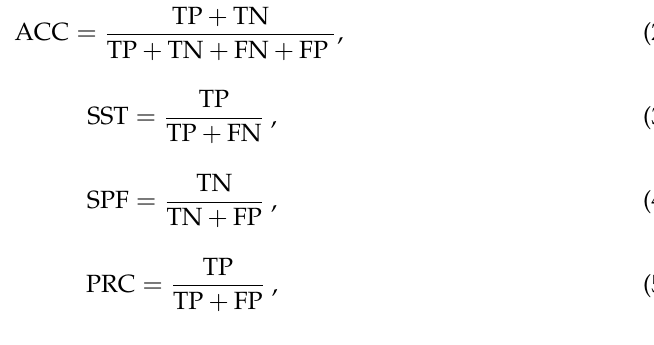
Table 1. Confusion matrix of a binary classification. Predicted Positive Predicted Negative Observed positive True Positive (TP) False Negative (FN) Observed negative False Positive